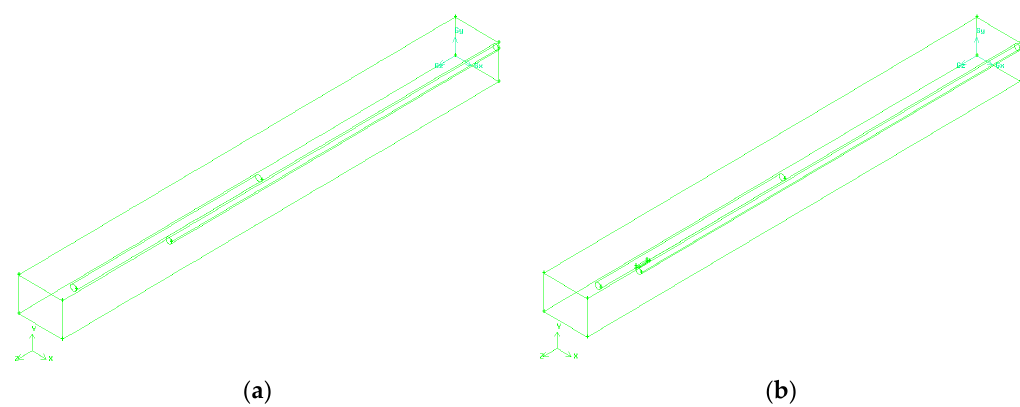
Figure 1. Geometry of working face for two different ventilation systems. ( a ) long blowing and short suction ventilation system; ( b ) vortex ventilation system.